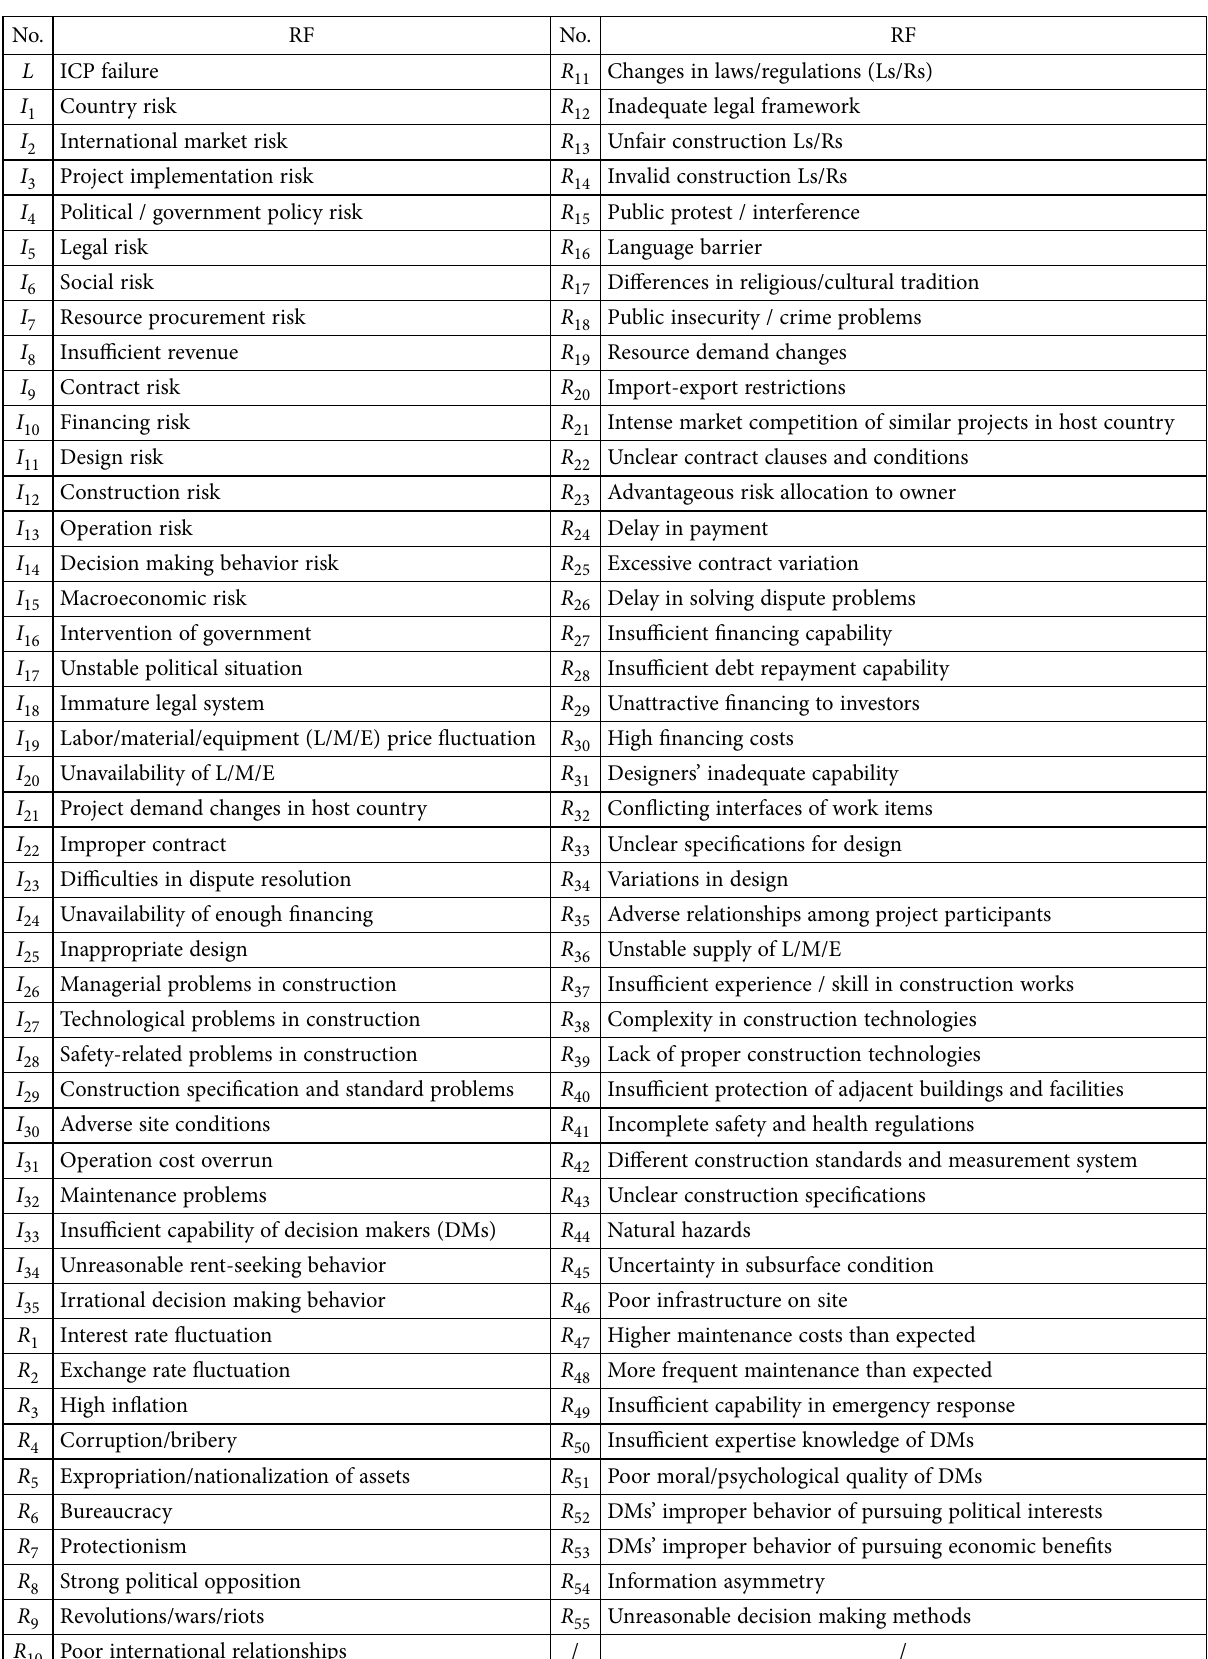
Table 2. The RFs of ICPs based on literature review and experts’ judgments No. RF No. RF L ICP